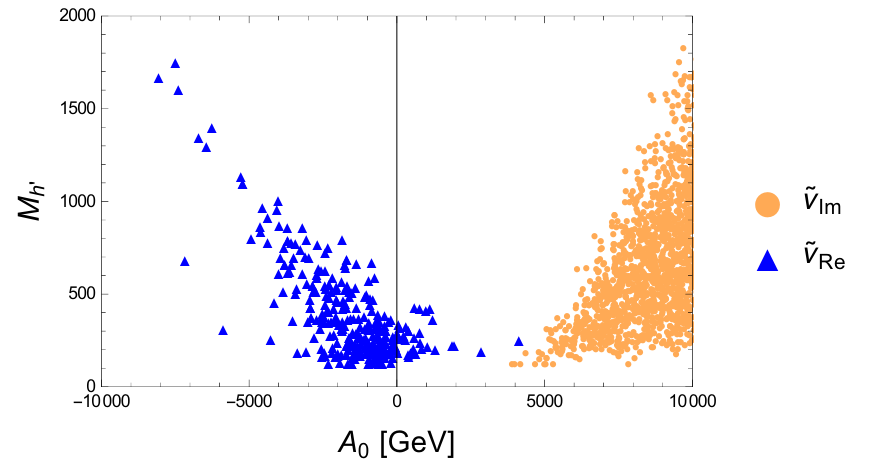
Figure 3 . Mass of lightest ( B (cid:0) L )-like Higgs versus the GUT parameter A LSPs (red) and CP-odd sneutrino LSPs